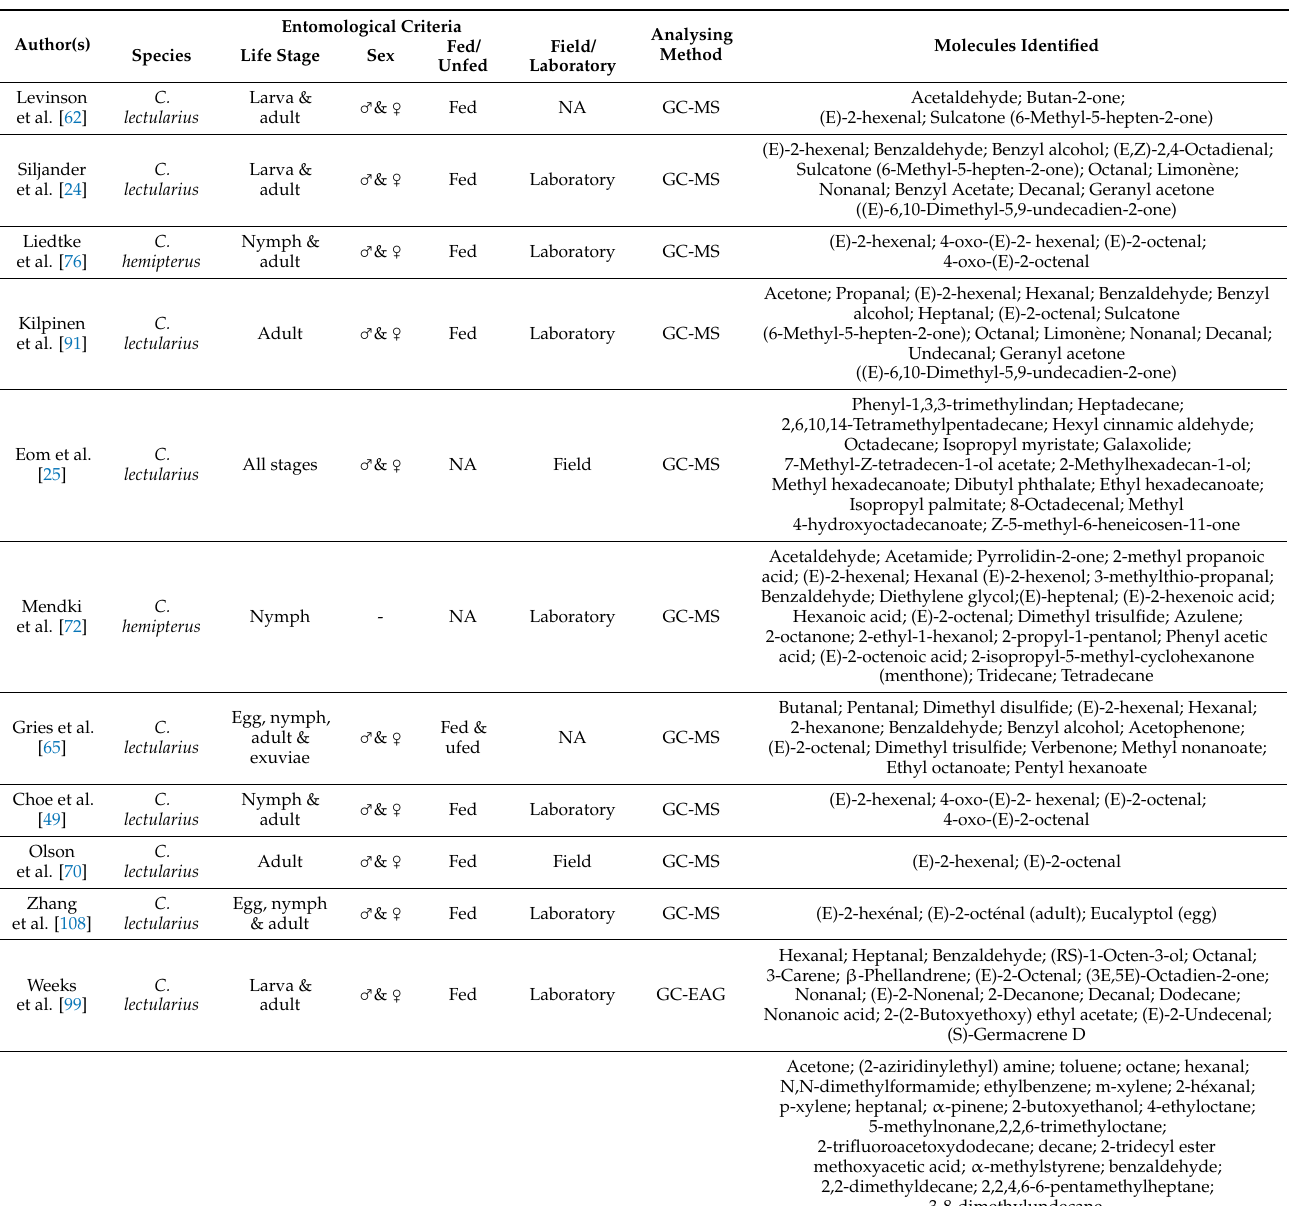
Table 3. Detailed profiles of investigations carried out on the bed bugs’ volatile organic compounds in the